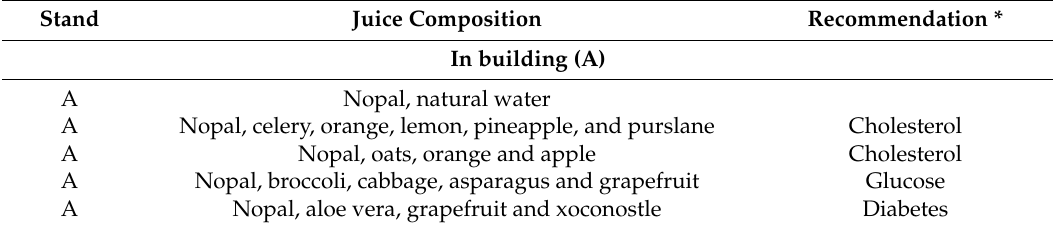
Table 1. Characteristics of fresh nopal juices collected monthly from June 2009 to May